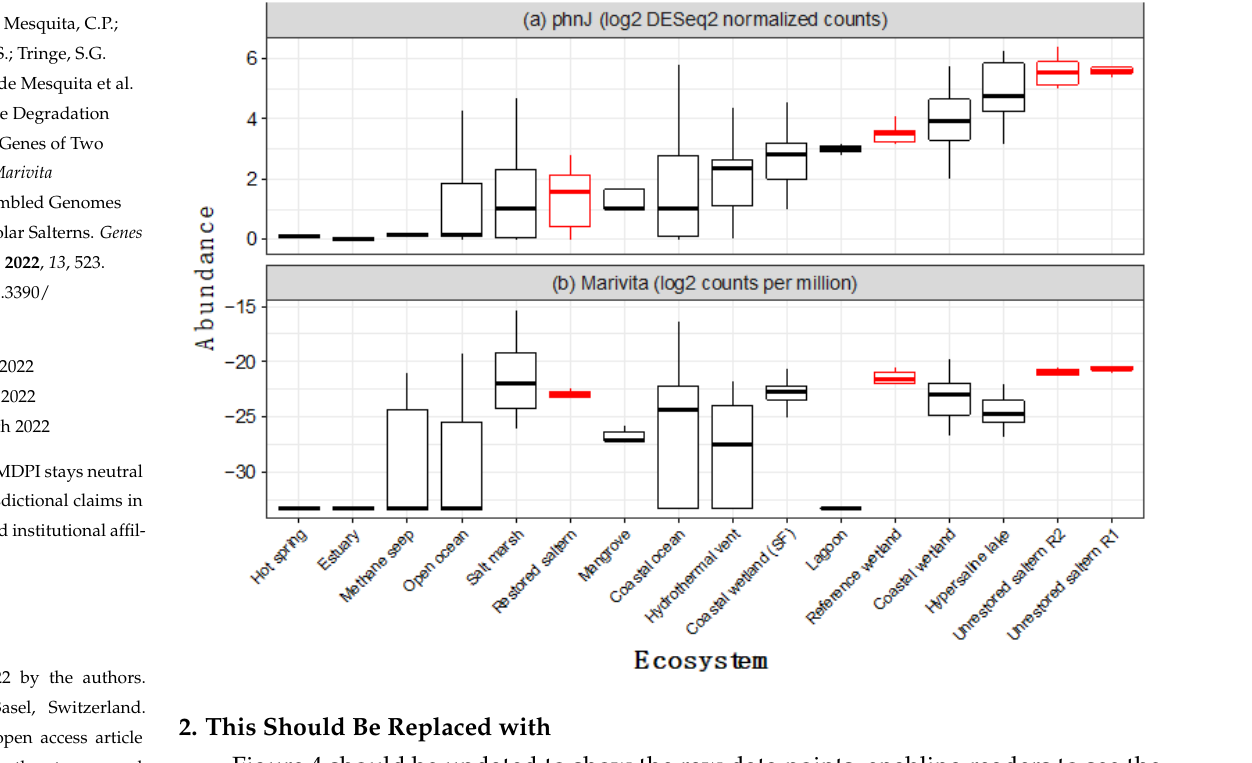
Figure 4 should be updated to show the raw data points, enabling readers to see the sample size of each ecosystem, as well as the full spread of variation in the data. The original article has been